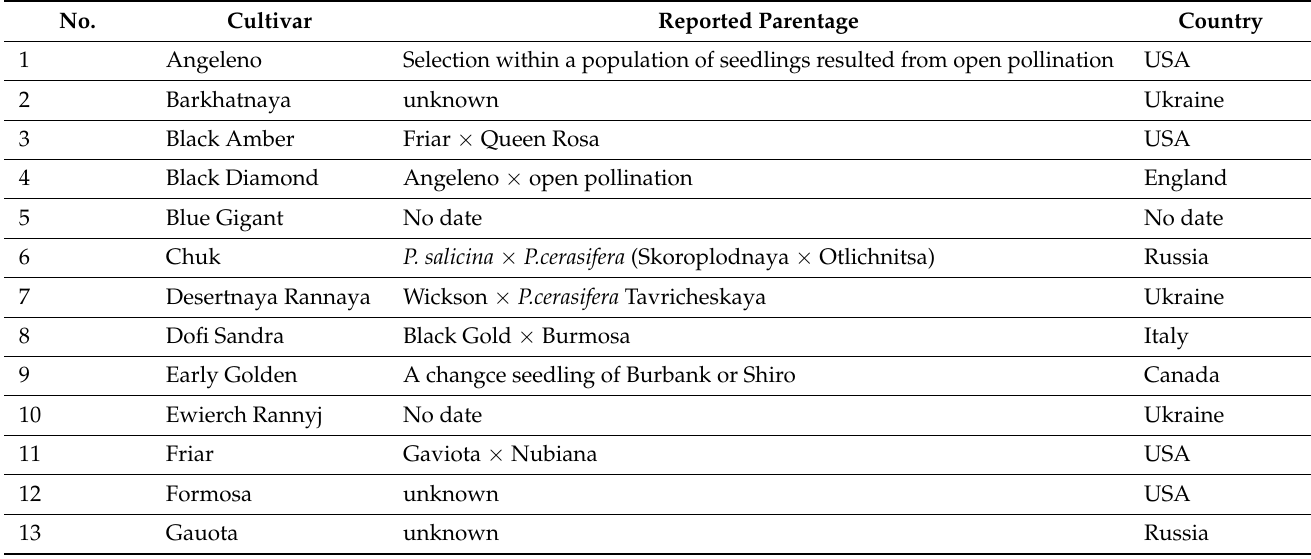
Table 5. List and information on plum cultivars studied. Source: